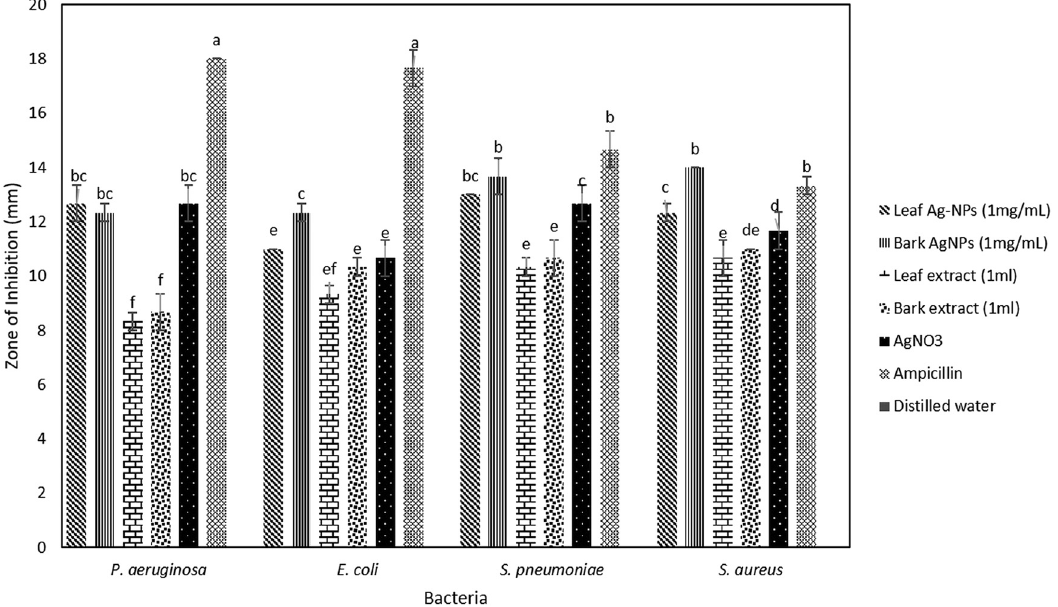
Figure 8: Antibacterial activity of Ag - NPs, plant extracts and controls, at P =